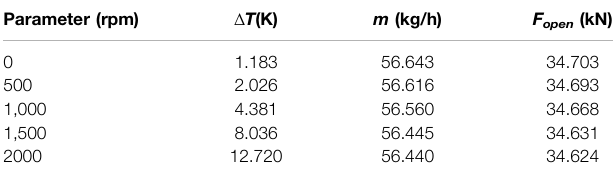
TABLE 3 | Performance of two kinds of speed.